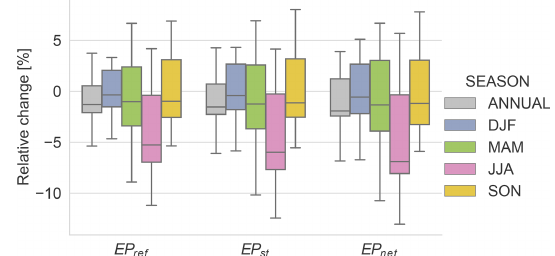
Figure 12. Boxplot of the change in energy production of the fu- ture Energy Island wind farm complex considering reference EP (no wake losses), standard EP (standard air density), and net EP (including wake losses and air density). The changes are computed between the past (1995–2014) and the future (2031–2050) in the various CMIP6 models (excluding